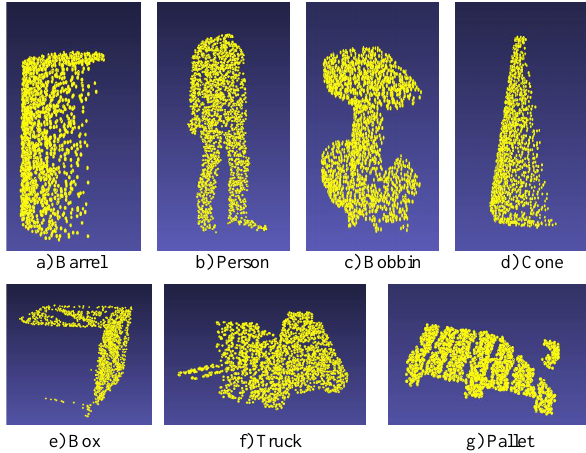
Figure 5. The simulated dataset from the factory model